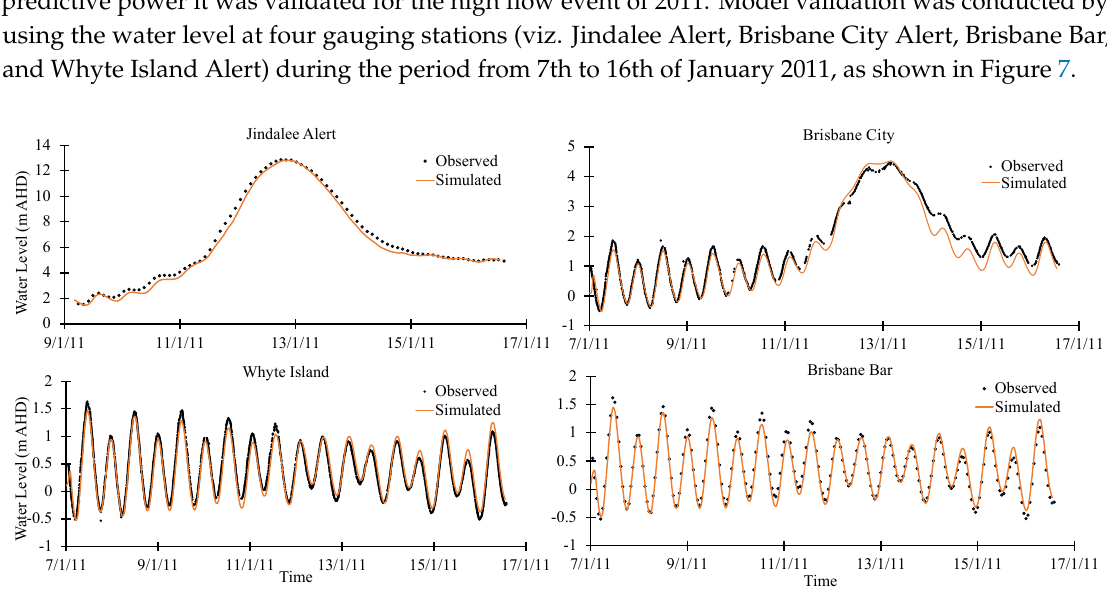
Table 5. Performance indices at gauging stations during calibration of the 2013 flood event.